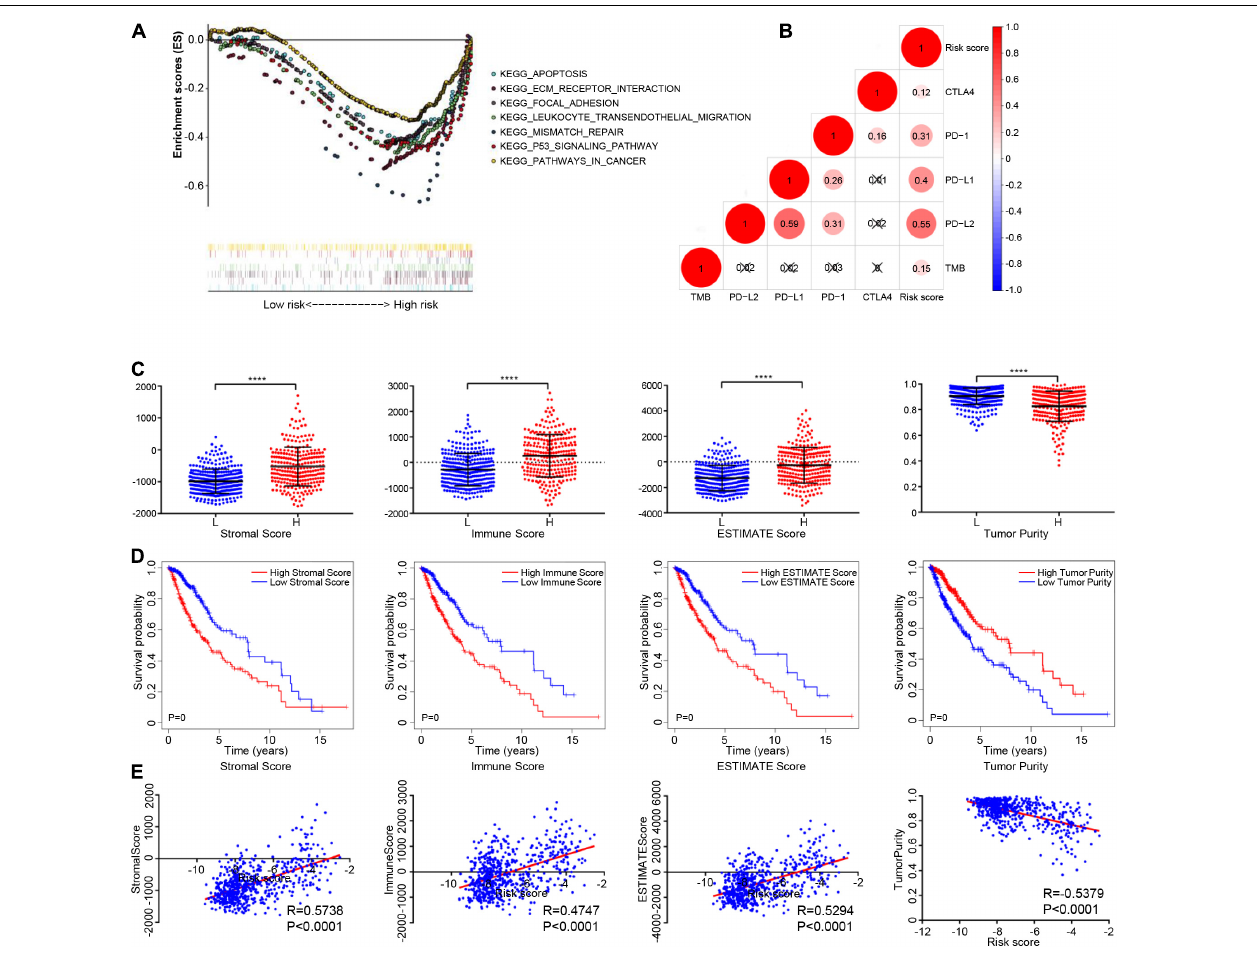
FIGURE 6 | The relationship between the epigenetic signature and immune cell infiltration. (A) GSEA showing the differences between high- and low-risk groups. (B) Correlation analysis between the risk score and immune checkpoint expression. (C) Distribution of stromal scores, immune score, ESTIMATE score, and tumor purity among high- and low-risk glioma patients. (D) Glioma patients were divided into two groups based on Stromal scores, immune score, ESTIMATE score, and tumor purity. K-M survival curve show overall survival of the low score group is longer than high score group, as indicated by the log-rank test. (E) Correlation analysis between the risk score and stromal scores, immune score, ESTIMATE score, and tumor purity. Abbreviations: K-M, Kaplan-Meier; ns, P > 0.05, **** P <